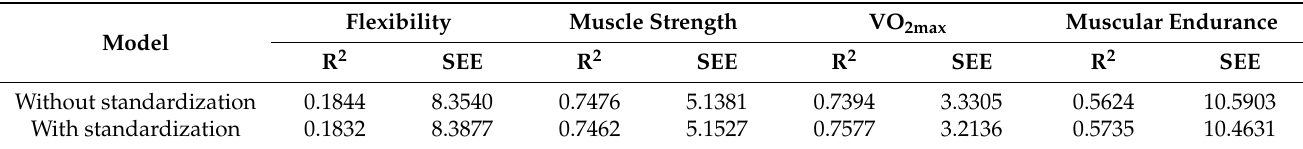
Table 3. Comparison of estimation accuracy according to the input data